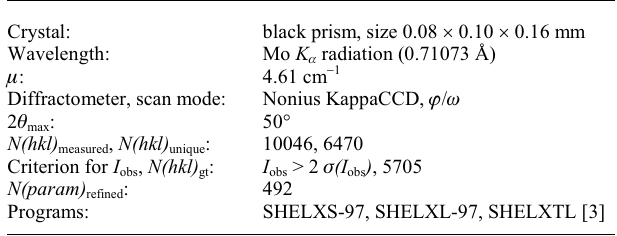
Table 1. Data collection and handling.